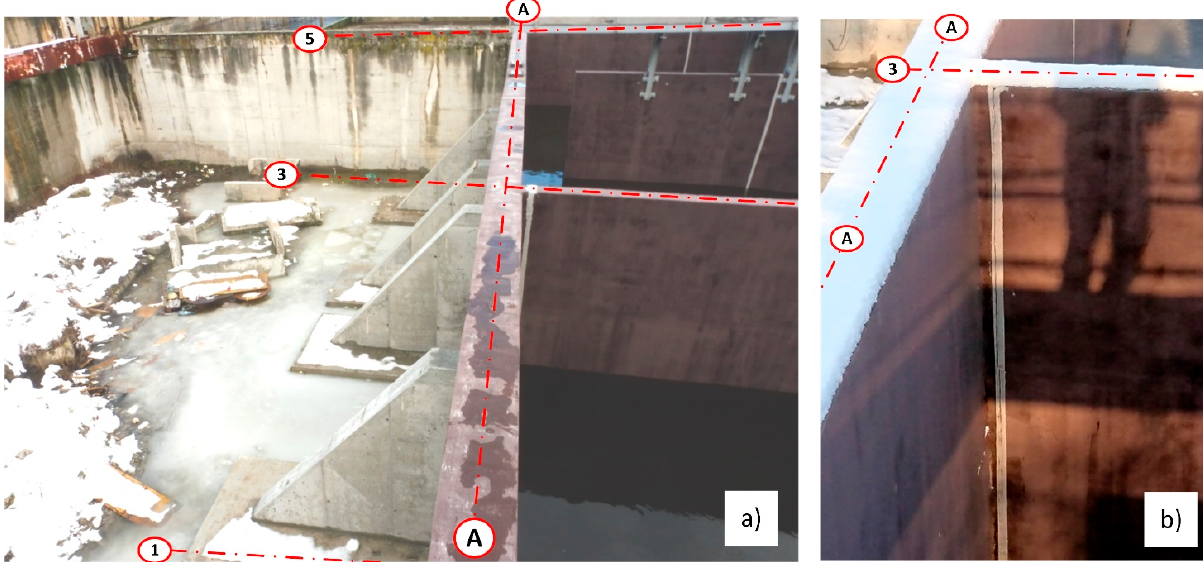
Figure 23. Strengthening of the wall of the biological reactor on the A axis with reinforced concrete supports.